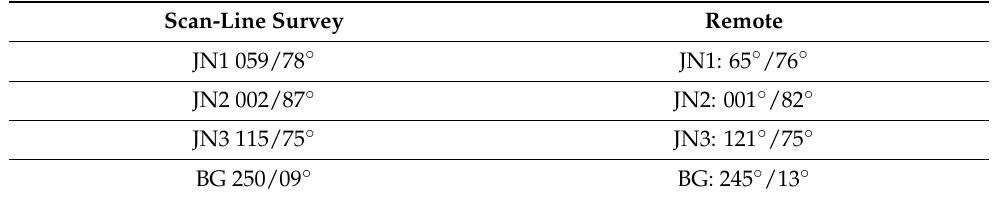
Table 2. Values (dip and dip direction) of joint families recorded by operators using classic scan-line survey and values of joint families extracted by the remote geo-mechanical